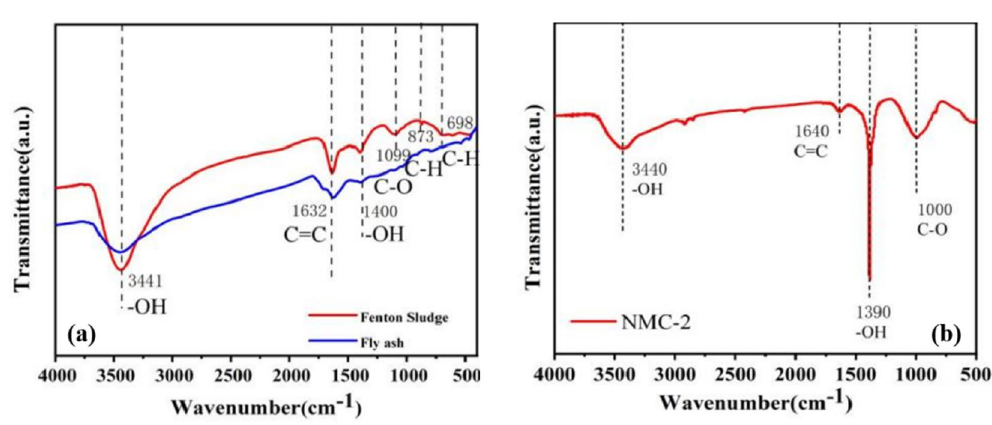
Figure 3. FTIR testing of materials: ( a ) FTIR image of Fenton sludge, fly ash, ( b ) Ftir image of NMC-2